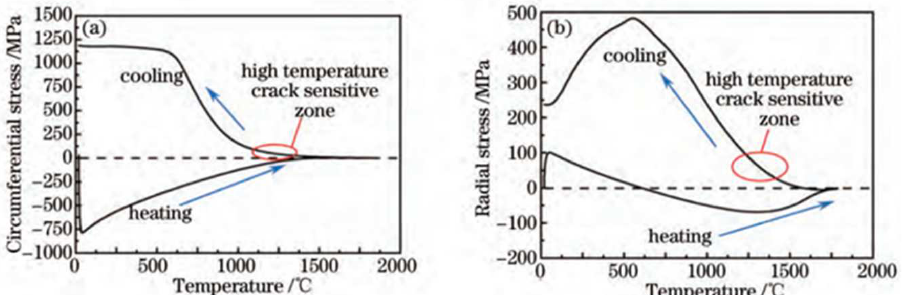
Figure 15. Temperature–circumferential of Inconel 718 alloy: ( a ) and temperature–radial; ( b ) stress curve in the cladding metal melting and solidification process [84].